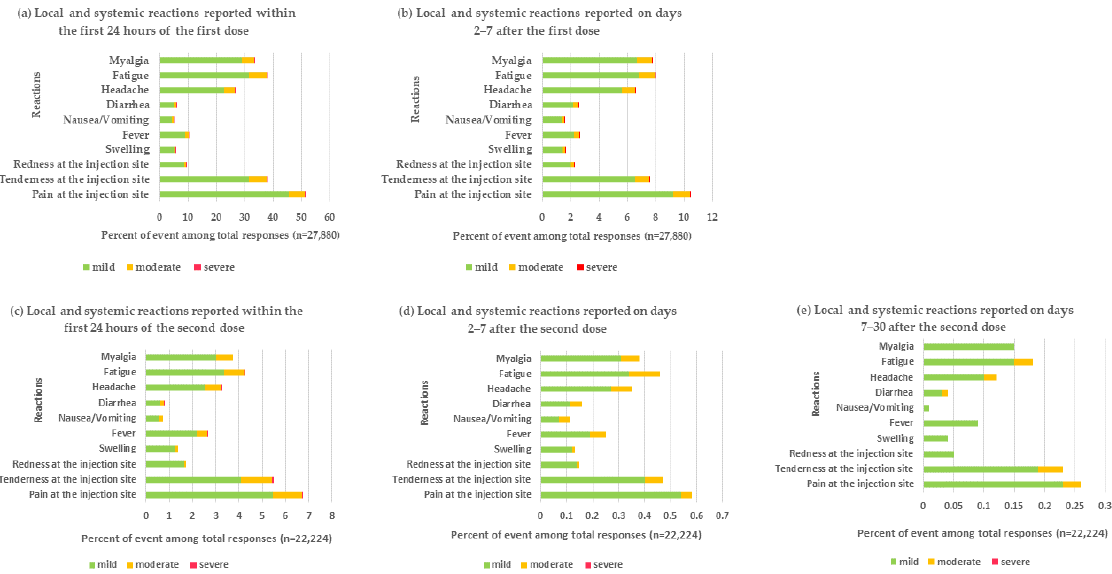
Figure 1. Local and systemic reactions reported within the first 24 h and days 2–7 of the first dose, and within the first 24 h, days 2–7, and days 7–30 of the second dose. Pain, tenderness, redness, and swelling were defined as local reactogenicity. Fever, nausea or vomiting, diarrhea, headache, fatigue, and myalgia were defined as systemic reactions. n: number of participants who responded to the questionnaire. ( a ) Local and systemic reactions reported within the first 24 h of the first dose. ( b ) Local and systemic reactions reported on days 2–7 after the first dose. ( c ) Local and systemic reac- tions reported within the first 24 h of the second dose. ( d ) Local and systemic reactions reported on days 2–7 after the second dose. ( e ) Local and systemic reactions reported on days 7–30 after the second dose. After the administration of the second dose of BBIBP-CorV, 1689 (7.60%) of 22,224 participants reported reactogenicity, which occurred within the first 24 h. The most com- mon symptoms were pain at the injection site (6.74%), tenderness at the injection site (5.49%), and fatigue (4.28%; Figure 1c). In the follow-up on days 2–7, the most common symptoms were similar to those experienced within the first 24 h, but were considerably less frequent (pain at the injection site (0.58%), tenderness at the injection site (0.47%), and fatigue (0.47%); Figure 1d). Most reactions were mild in severity (Figure 1d). The compar- ison of the local and systemic reactions reported within the first 24 h and days 2–7 of the first and second dose of BBIBP-CorV in participants aged 10–17 years are shown in Figure 2.